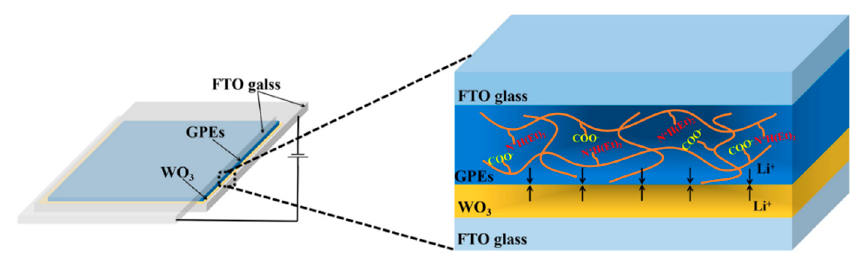
Figure 2. The assembly process of the electrochromic device (ECD).